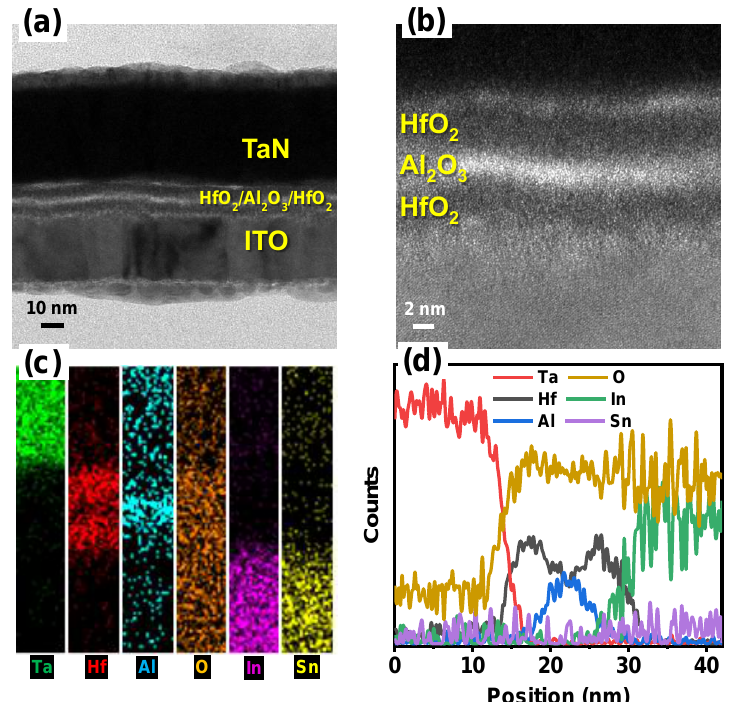
Figure 2. ( a , b ) Cross-sectional high-resolution transmission electron microscopy (HRTEM) image of TaN/HfO 2 /Al 2 O 3 /HfO 2 /ITO tri-layer RRAM structure; ( c ) EDS elemental mapping; ( d ) line profiles of Ta, Hf, Al, O, In, and Sn for the cross-section of the device. After applying a negative bias at the electrode, oxygen vacancies are piled up mainly near the interface driven by the external electric field. The virtual electrode (formed during electroforming process) at both ends within HfO 2 helps to regrow the CF. During RESET process, the CF is not fully ruptured, and V O recombines with oxygen ions gradually due to the applied positive bias at the top electrode, as shown in Figure 4. According to previous studies, asymmetric CF forms inside two different dielectrics. This further leads to formation of the weakest CF at the interface of two different dielectrics [14,32]. Hence, the redox reaction due to the migration of oxygen ions dominates the RESET process near the interface of two dielectrics, as described, with the switching mechanism in Figure 4 [20,32].The endurance characteristics were obtained for the tri-layer RRAM device with up 1.510 -9 -1.5 -1.0 -0.5 0.0 0.5 1.0 to 1300 cycles with I on /I off ratio > 10, as shown in Figure 3c, read at 0.1 V. Initial variation of low resistance state (LRS) and high resistance state (HRS) can be due to the large area of the top electrode, where a large number of conductive filaments are created during the forming process. Data retention at a read voltage of 0.1 V, for LRS and HRS, was recorded up to 10 4 s without any significant variation, as shown in Figure 3d. To understand the performance of the proposed tri-layer RRAM device, a detailed comparison of electrical parameters is presented in Table 1.